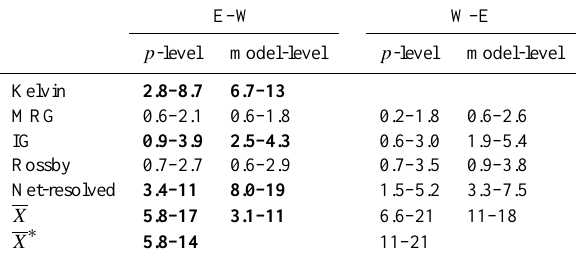
Table 2. Phase-maximum magnitudes of the Kelvin, MRG, IG, and Rossby wave forcing, net-resolved wave forcing, X , and X [ms − 1 month − 1 ] at 30hPa in the E–W and W–E phases for the pe- riod 1979–2010, obtained using the p -level data sets and the ERA-I model-level data set. Details of X and X text along with Eqs. (1) and (4). Positive forcing is denoted by bold font.